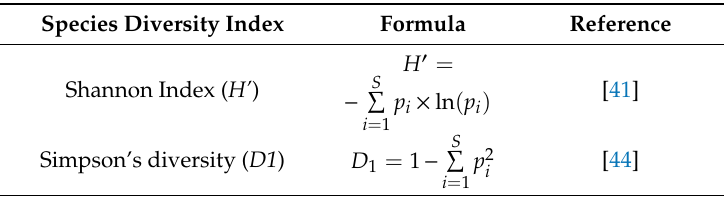
Table 2. Diversity indices used in the